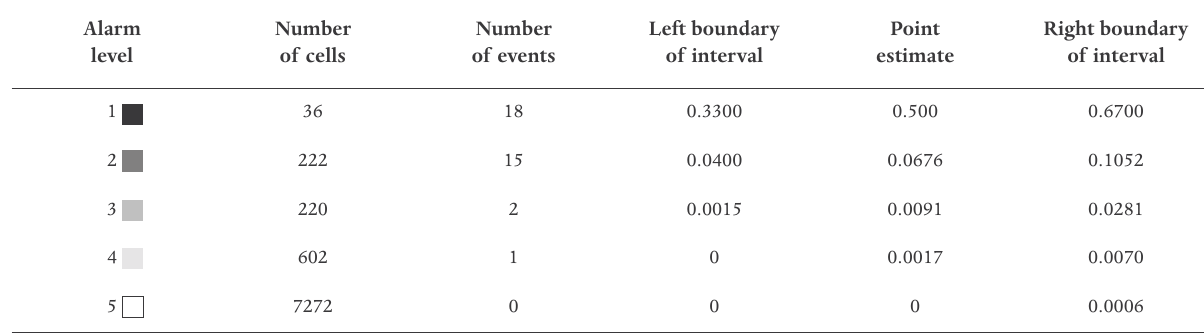
Table 2. Number of events and alarm cells for each level of the retrospective analysis for SAE